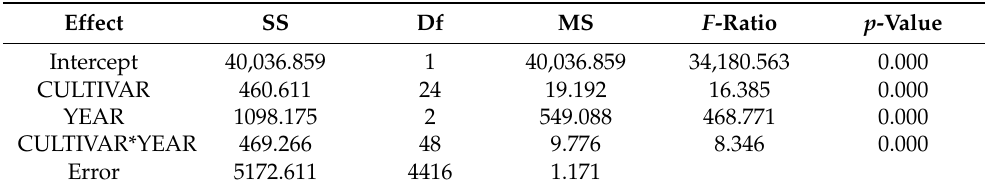
Table 1. The ANOVA results for the visual assessment of the wheat cultivars inoculated by eyespot (2019–2021).